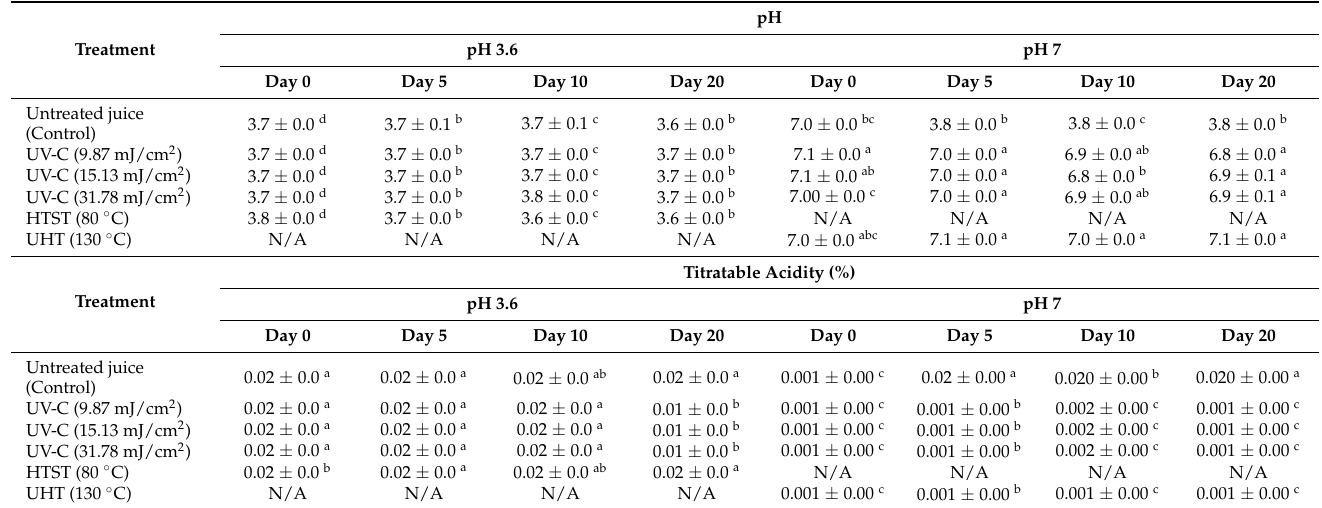
Table 3. Effect of UV-C irradiation and thermal treatment on pH and acidity of red prickly pear